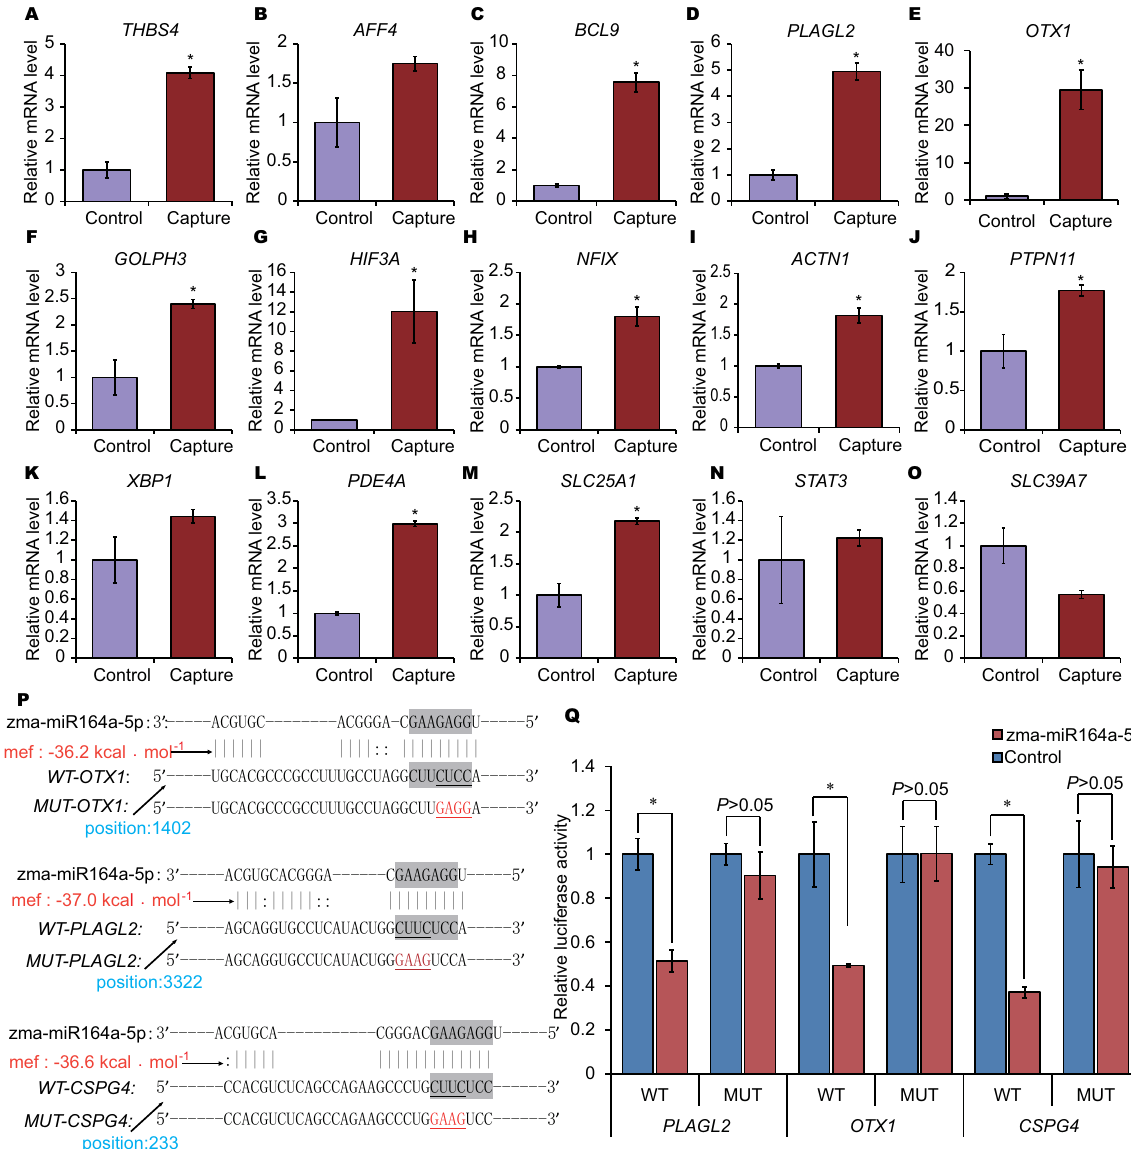
Figure 5. Possible cross-kingdom regulation of target porcine mRNAs by maize miRNAs. ( A–O ) Potential target genes of zma-miR164a-5p were captured in a porcine kidney cell line (PK15) using the MirTrap System. The fold enrichment and statistical significance of the potential target genes were identified by qRT-PCR ( n = 3). ( P ) Diagram of the putative zma-miR164a-5p binding sites in OTX1 , PLAGL2 and CSPG4 , and luciferase reporter plasmids containing wild-type (WT) or mutant (MUT) putative zma-miR164a-5p target sites. Paired bases are indicated by black vertical lines and mispairing is indicated by two dots. ( Q ) Luciferase activity in the porcine kidney cell line (PK15) co-transfected with zma-miR164a-5p or negative control oligos and the reporter constructs from ( P ) ( n = 3). Statistical significance was determined by Student’s t -test ( * P <